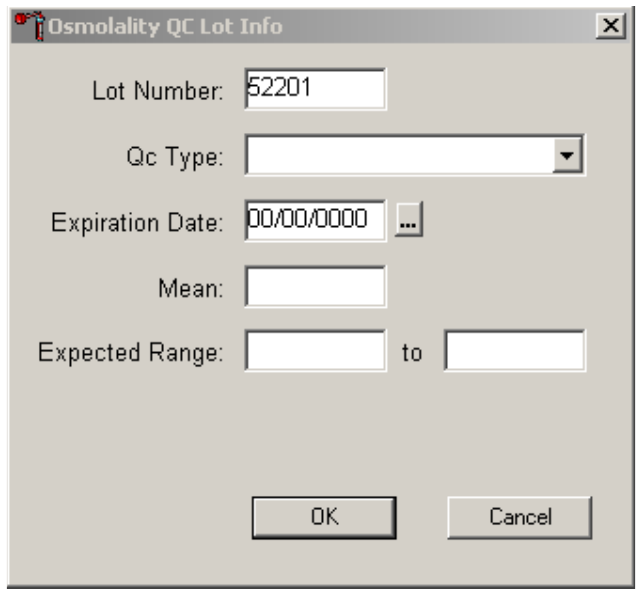
Direct the mouse over the Lot Number field and left click. Use the number pad on the keyboard to enter the lot number on the package